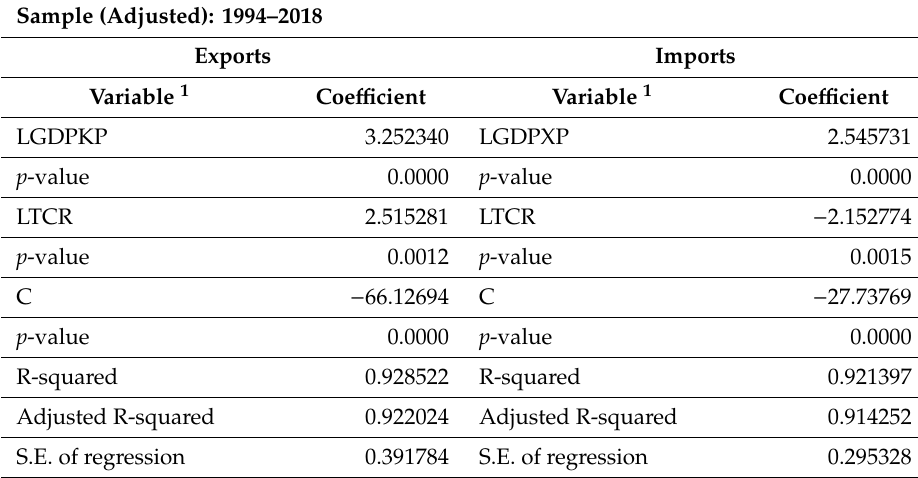
Table 14. Results for the Export and Import Equations,